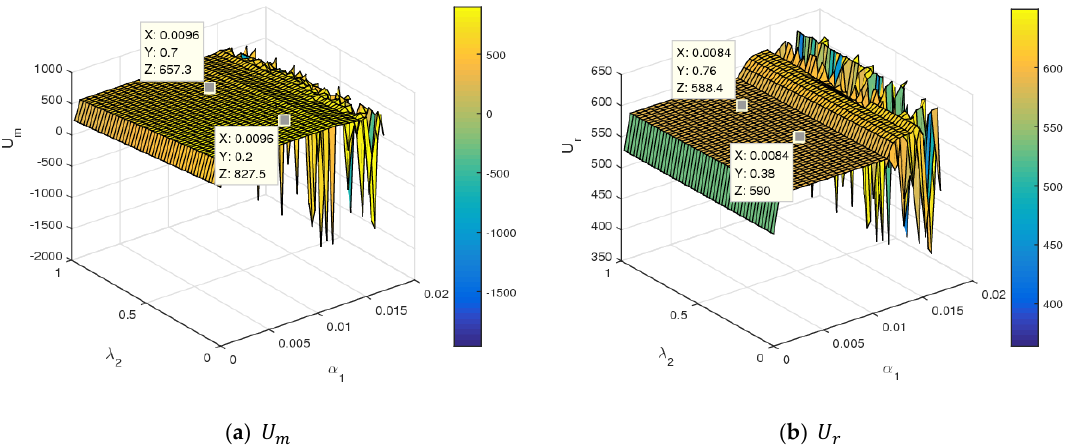
Figure 15. The utility changes of the manufacturer and retailer with respect to 𝛼 1 and 𝜆 2 .